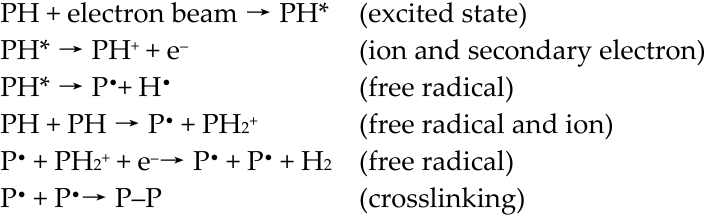
Scheme 1. The outline of some reactions illustrating typical physico-chemical transformations on polymers (P—polymer chain).